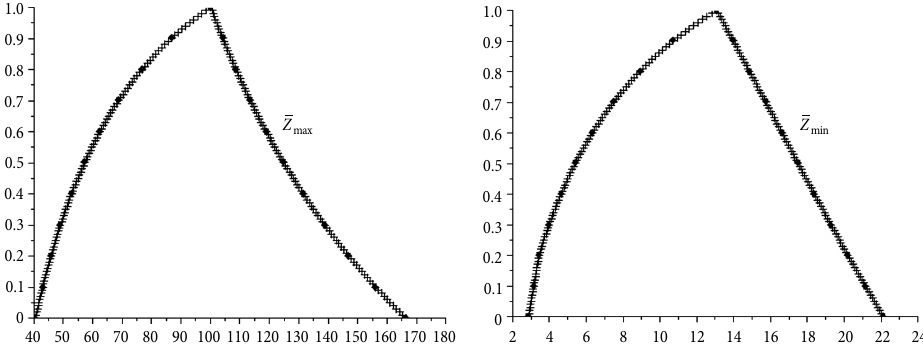
Fig. 6. The shapes of max Z (for the maximal 1 X , 2 X ) and min Z (for the minimal 1 X , 2 X